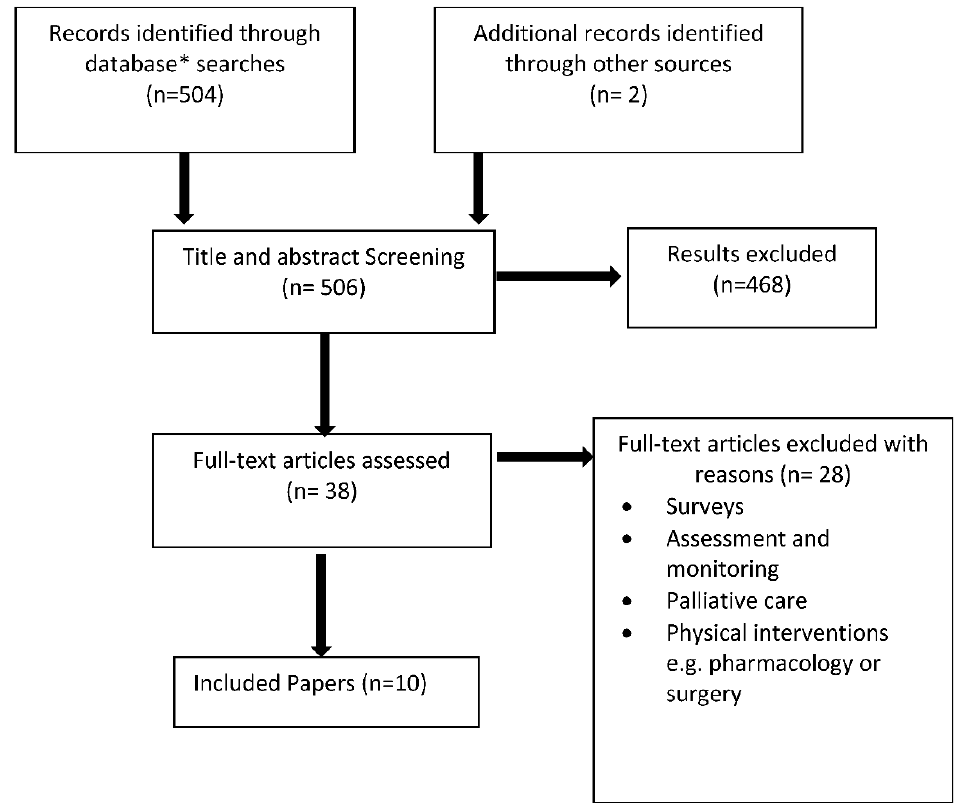
Figure 1. Study selection diagram. * No additional papers were identified from PubMed or Science Direct.